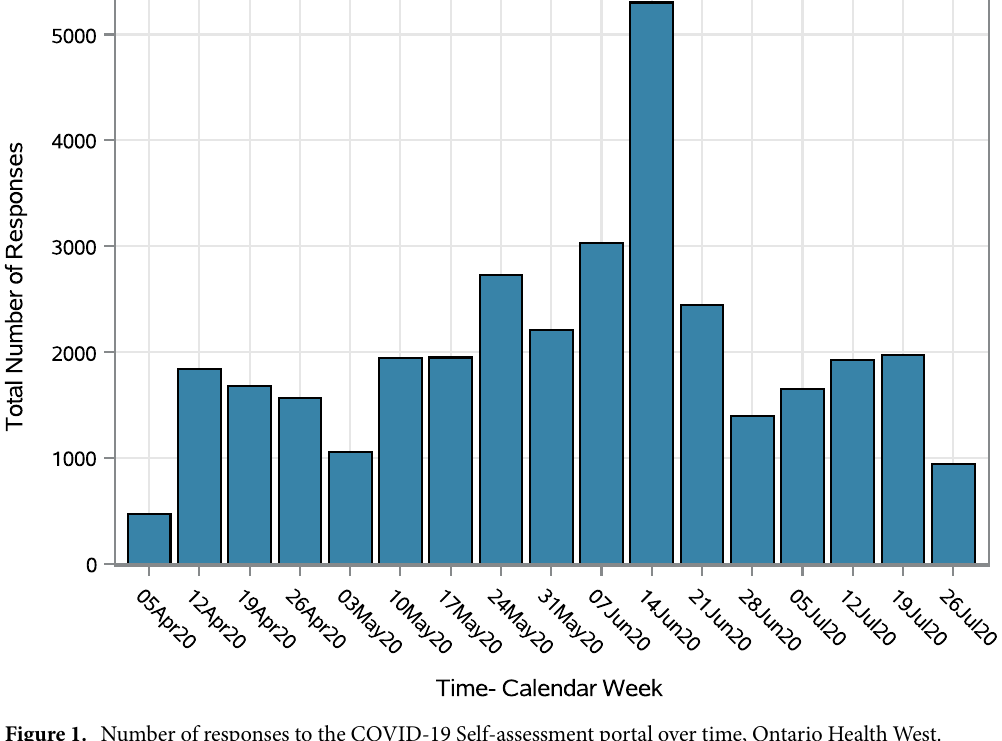
Figure 1. Number of responses to the COVID-19 Self-assessment portal over time, Ontario Health West.